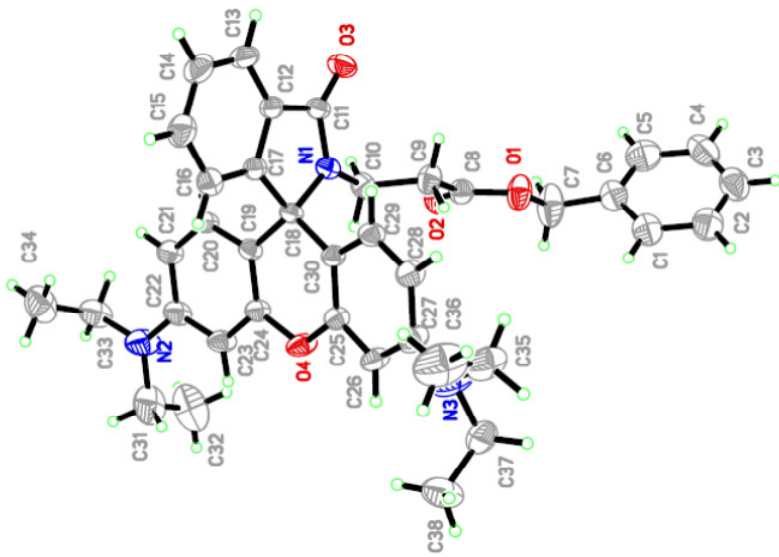
Figure 2. Crystal structure of RBAP